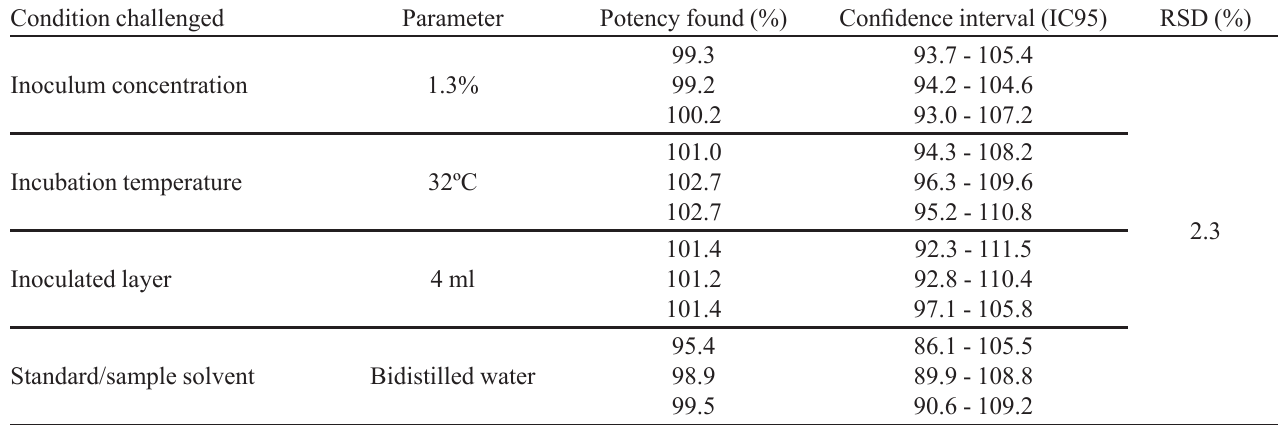
Condition challenged